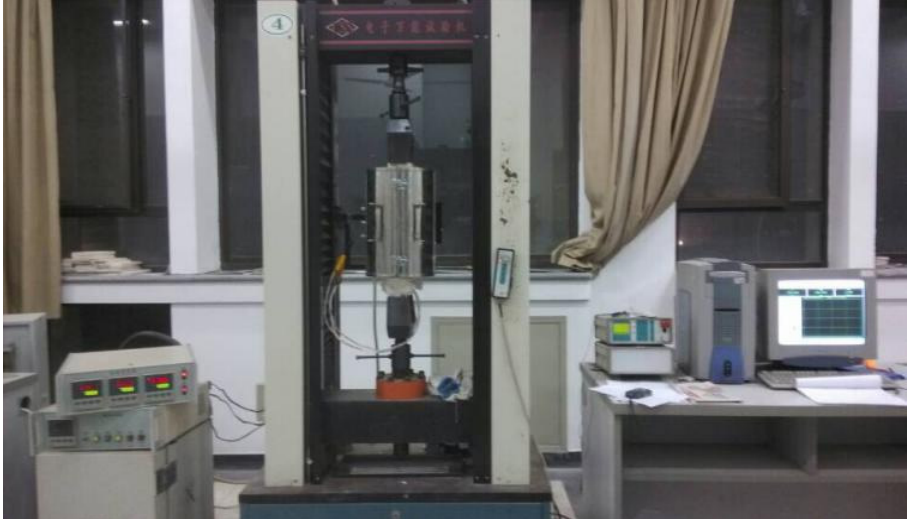
Figure 1. Test system for the experiments.